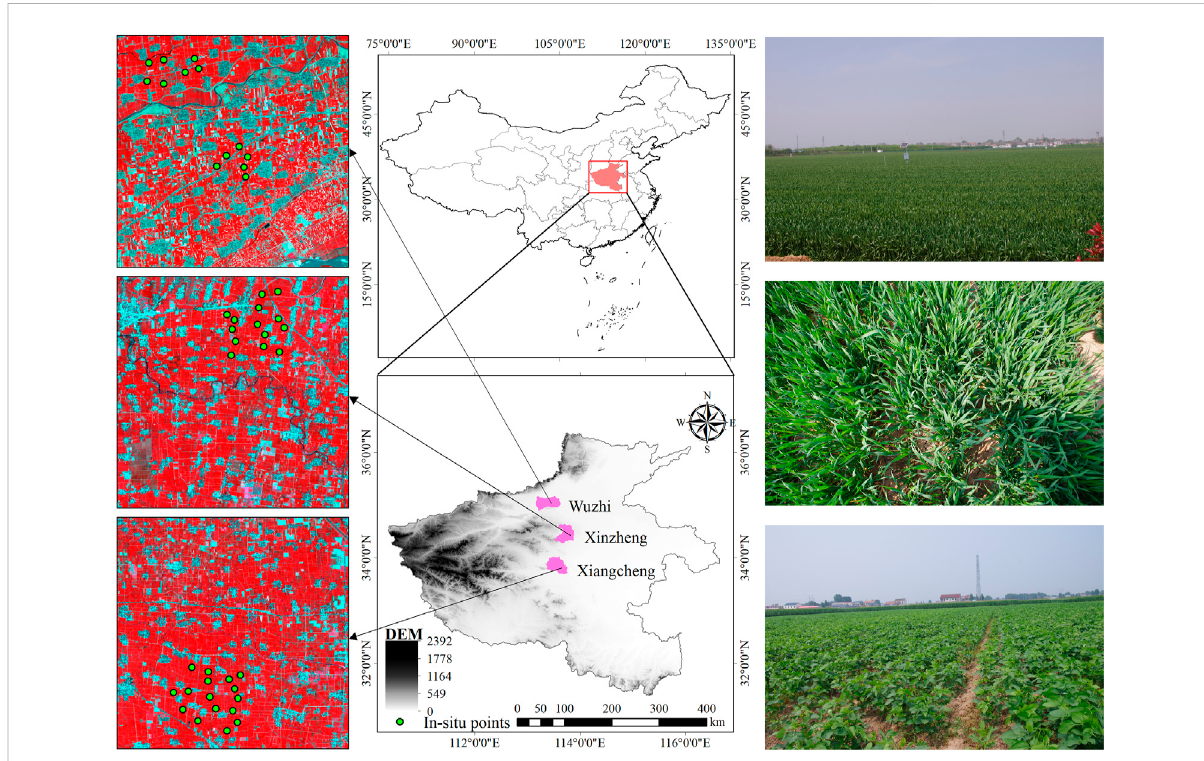
FIGURE 1 Locations of Wuzhi, Xinzheng, and Xiangcheng in Henan province, China. The left side was a 30-m spatial resolution Landsat-8 OLI standard false-color composite image (band 5, band 4, and band 3 of the OLI instrument were used as R, G, and B bands, respectively). Locations of in situ measurements are displayed as green points. The right side is part of the fi eld scene photographs of the in situ LAI.